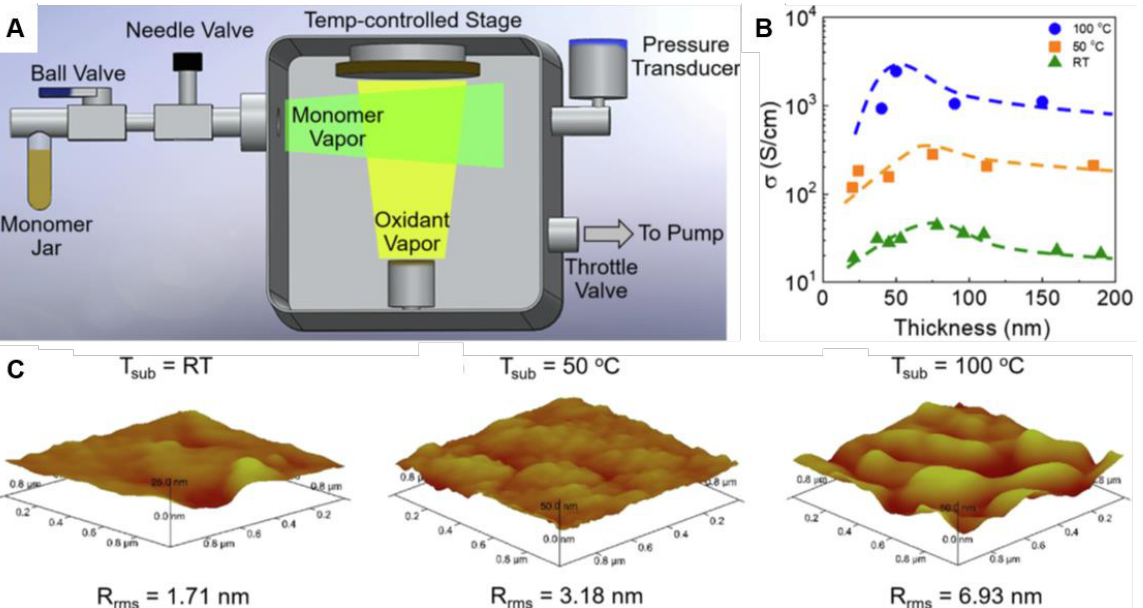
Figure 3. Scheme of a CVD reactor ( A ). Conductivity as a function of T SUB and film thickness ( B ). AFM topographic images of CVD PEDOT at different T SUB ( C ). Adapted with permission from reference [55]. Copyright 2020 Elsevier.